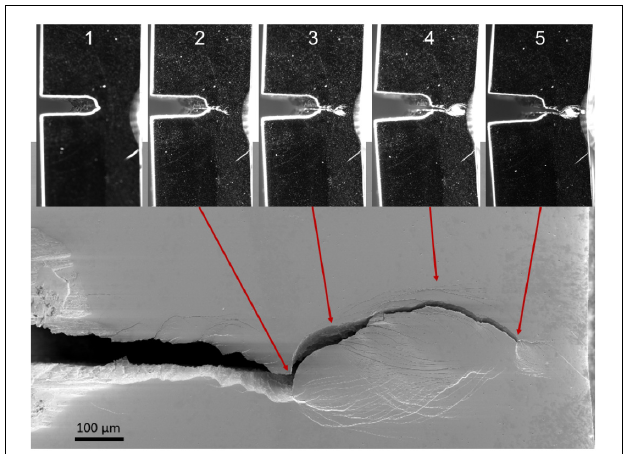
FIGURE 8 | Crack propagation of pre-notched Vit 105 sample under three-point-bending (3PB) conditions.